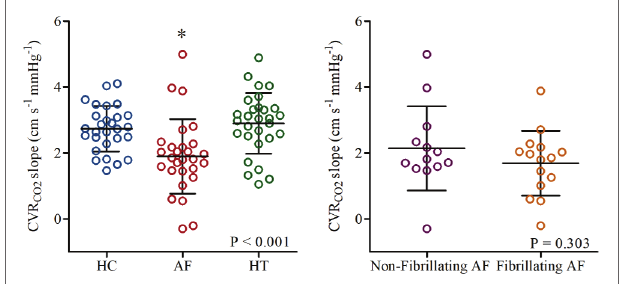
FIGURE 1 | Cerebrovascular carbon dioxide reactivity (CVR CO2 slope) in healthy controls (HC: blue), patients with atrial fibrillation (AF: red), and hypertension (HT: green). Responses in AF-sub-groups (non-fibrillating and fibrillating AF patients) are shown on the right. Horizontal bars show mean and standard deviation (SD) for each group. * p < 0.05 vs. HC and HT. Reproduced from Junejo et al. (2019b; open access article – Elsevier